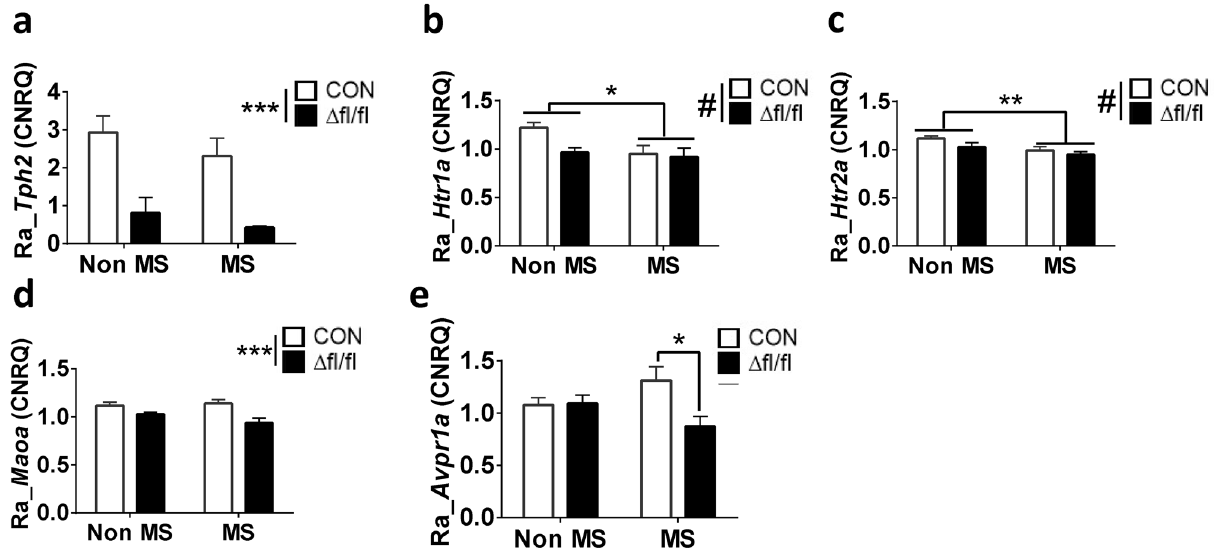
Figure 5. Expression of genes representing markers of 5-HT system function in the raphe region of MS-exposed Tph2 icKO mice with homozygous genetic predisposition. After behavioral testing maternally separated (MS) and normally reared non-MS Tph2 fl/fl::Tph2CreERT2 (fl/fl) mice, which were either injected at 10–12 weeks of age with TAM (Δfl/fl) or vehicle (CON) were analysed for differential expression of ( a ) Tph2 , ( b ) Htr1a , ( c ) Htr2a , ( d ) Maoa , ( e ) Avpr1 . Data are shown as mean ± SEM. #0.05 < p < 0.1, ** p < 0.01 and *** p <